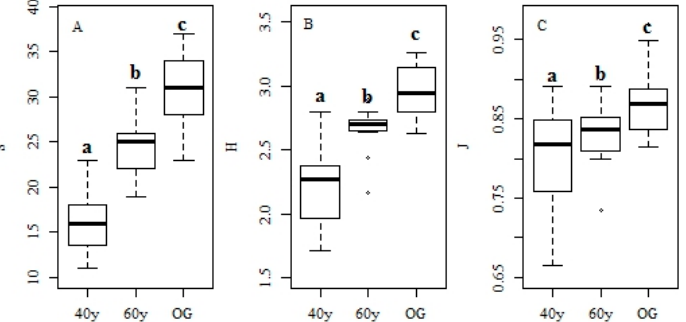
Figure 3. The changes in species diversity (mean ± SD) with secondary succession of monsoon forests. Subfigures ( A – C ) respectively showed the changes of species richness (S), Shannon -Weaver index (H) and Pielu’s evenn. The successional stages were 40-year-old forests (40y), 60-year-old forests (60y) and old-growth forests (OG). Different letters (a, b, c) demonstrated significant different at p < 0.05.